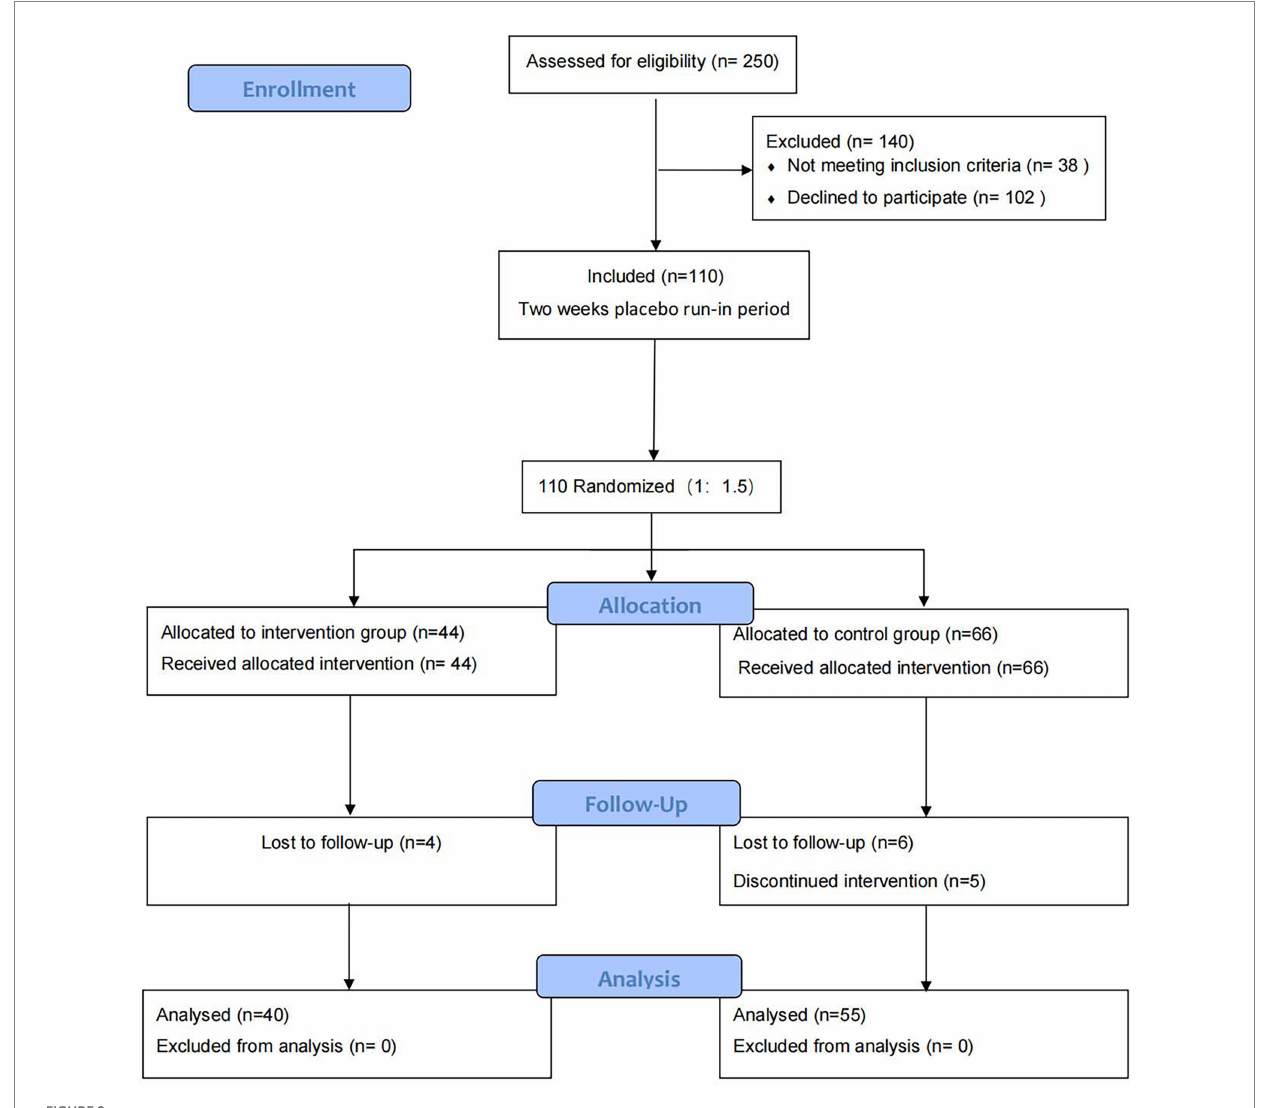
FIGURE 2 Flow diagram of trial